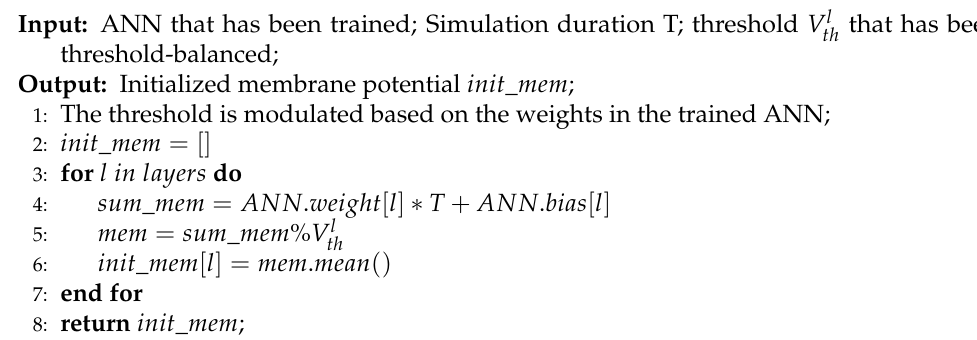
Algorithm 1 Initialized membrane potential based on a trained